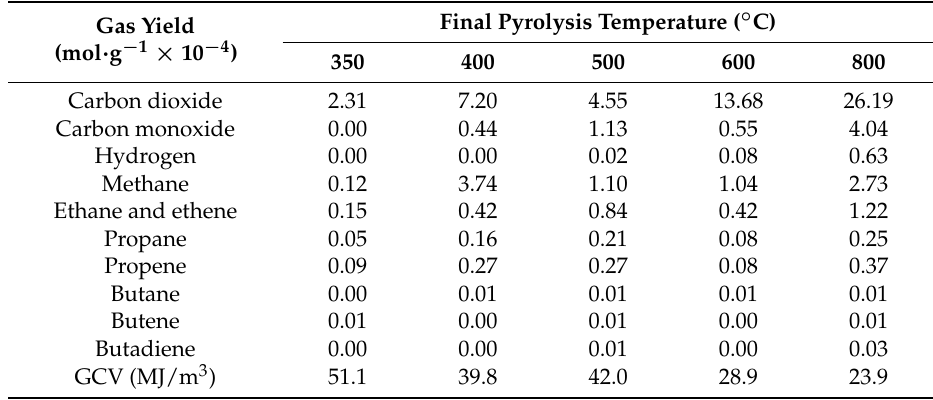
Table 7. Total yields of gases derived from the pyrolysis of EP in relation to final pyrolysis temperature. Adapted from [26], with permission from © 2003